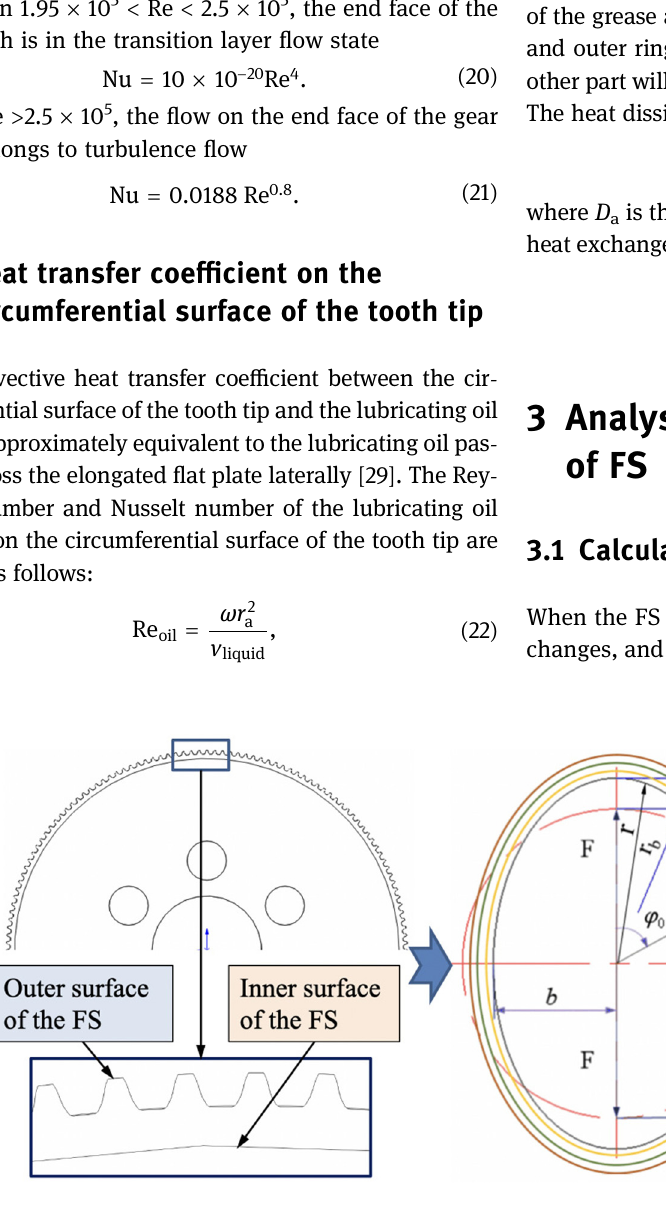
Figure 4: Deformation curve of FS under cosine